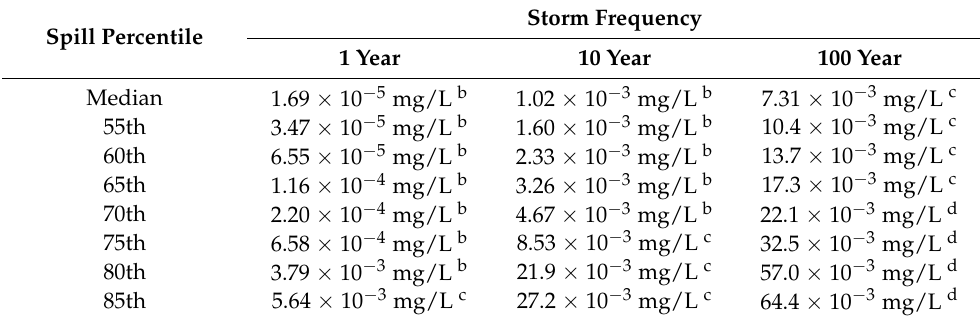
Table 6. Maximum concentrations a predicted for produced water spill and storm simulations considering a 2 ft groundwater table, assuming no degradation and no